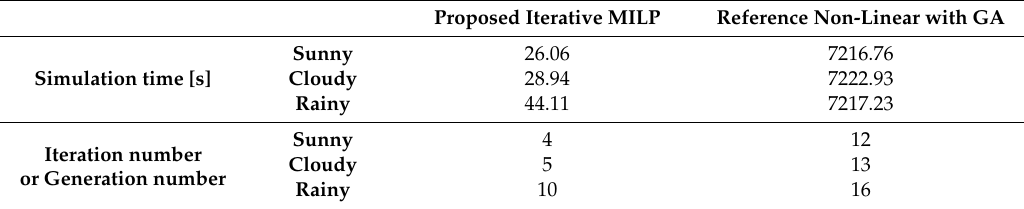
Table 5. Computational performances of solution algorithms for the three typical